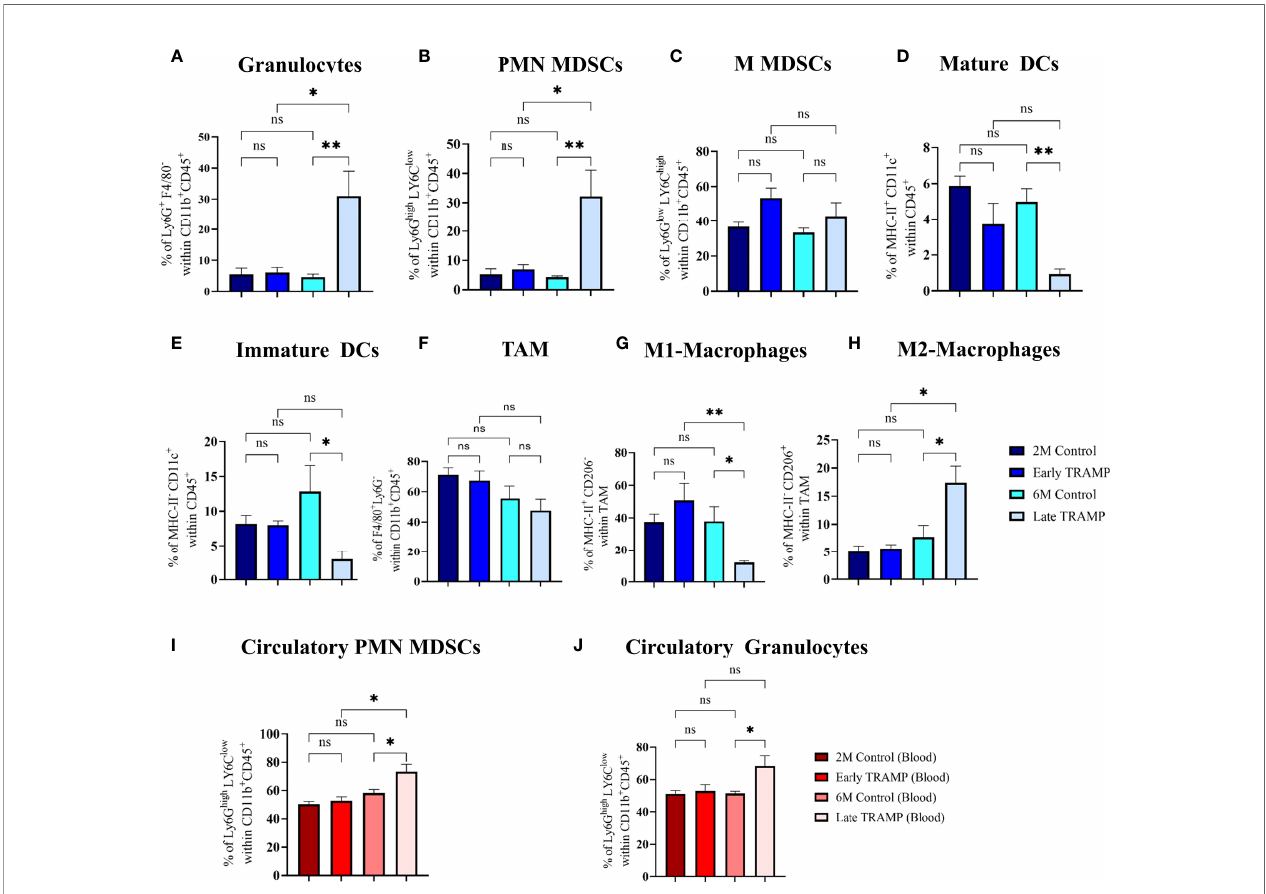
FIGURE 5 | Tumour-stage-speci fi c altered tumoural, and circulatory innate immune landscape. Control and tumour tissues were harvested at the indicated time points, single-cell suspensions were prepared and immune-phenotyped to characterize different innate immune cells like (A) Granulocytes (Ly6G + F4/80 - ); (B) Polymorpho-nuclear myeloid-derived suppressor cells (PMN-MDSCs) (Ly6G high LY6C low ); (C) Monocytic MDSCs (MMDSCs) (Ly6G low LY6C high ); (D) Mature dendritic cells (DCs) (MHC-II + CD11c + ); (E) Immature DCs (MHC-II - CD11c + ) (F) Tumour associated macrophages (TAM) ( F4/80 + Ly6G) (G) M1 macrophages (MHC-II + CD206 - F4/80 + Ly6G - ); (H) M2 macrophages (MHC-II - CD206 + F4/80 + Ly6G - ). Circulatory PMN-MDSCs and granulocytes were analysed using peripheral blood (I, J). n=4-5/group (tissue), n=5-7/group (blood)E; Data are represented as mean ± SEM. Statistical signi fi cance was determined using one-way ANOVA followed by Tukey ’ s multiple comparisons test, ns, Non-signi fi cant; (*p < 0.05, **p <